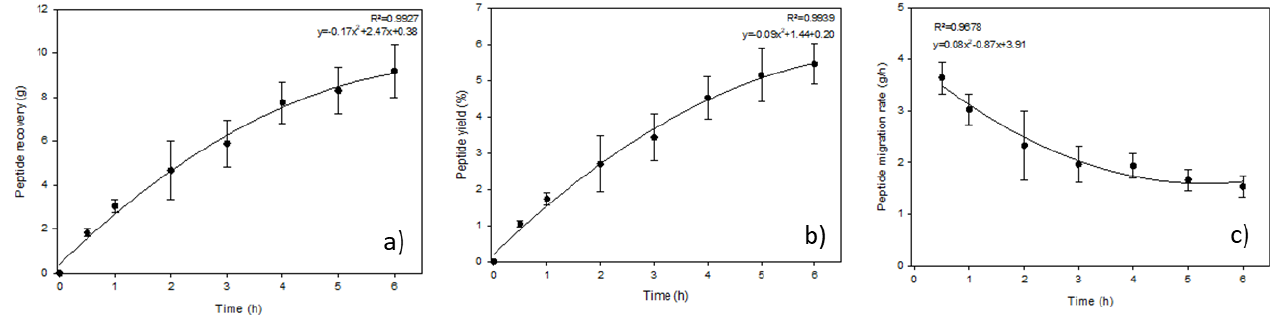
Figure 3. Evolution as a function of time of ( a ) peptide recovery, ( b ) peptide yield and ( c ) peptide migration rate in the peptide recovery fraction.